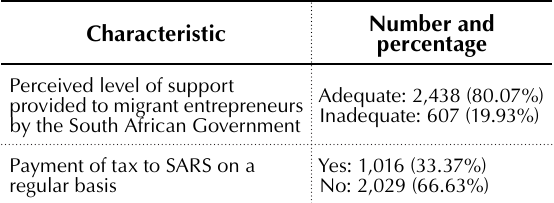
Table 4. Perception on level of support to